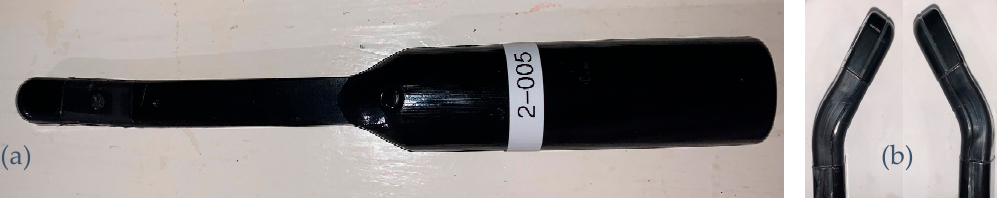
Figure 2. Handheld intraoral scanner pen system designed and constructed by our team: ( a ) scanner pen with extended reach to improve intraoral access, ( b ) flexible tip permitting imaging access to all intraoral sites, including base of tongue and tonsillar region.